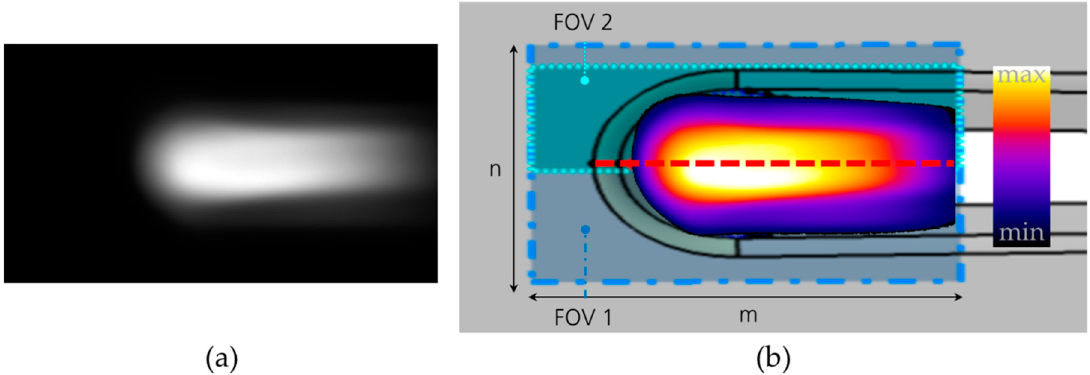
Figure 8. Correlation between thermographic and geometric information of the process: ( a ) Gray value of the process light during the cut; ( b ) Conversion of the gray value into corresponding temperature distribution super positioned with geometry of the cut kerf.